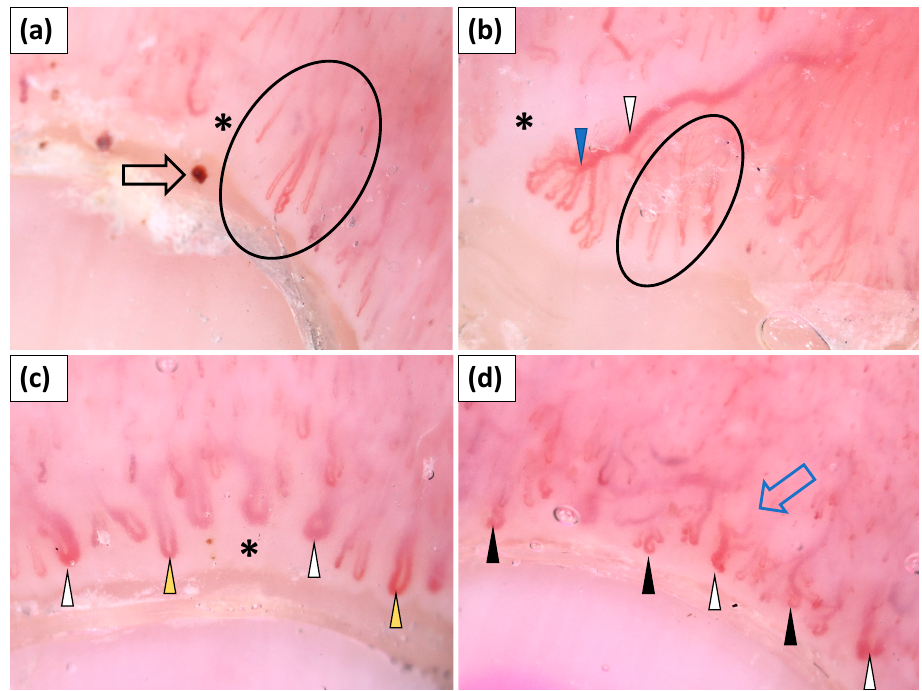
Figure 1. ( a – d ) Videodermoscopy of nailfold capillaries showed the presence of elongated capillaries (black circle), tortuous vessels (black arrowhead), “bushy capillaries” (blue arrowhead), dilated vessels (yellow arrowhead), giant capillaries (white arrowhead), hemorrhages (black arrow), avascular areas (black asterisk), and disorganized vessel architecture (blue arrow).